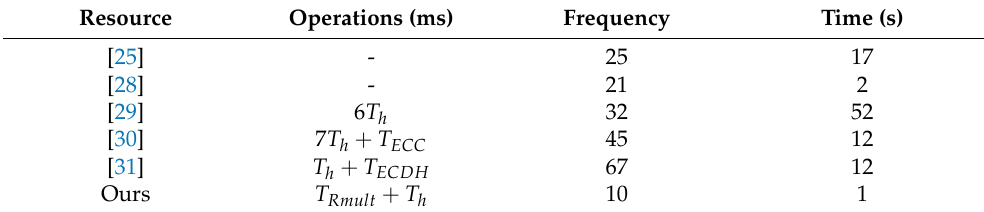
Table 10. Execution time of the TLS handshake using the MICAz sensor.